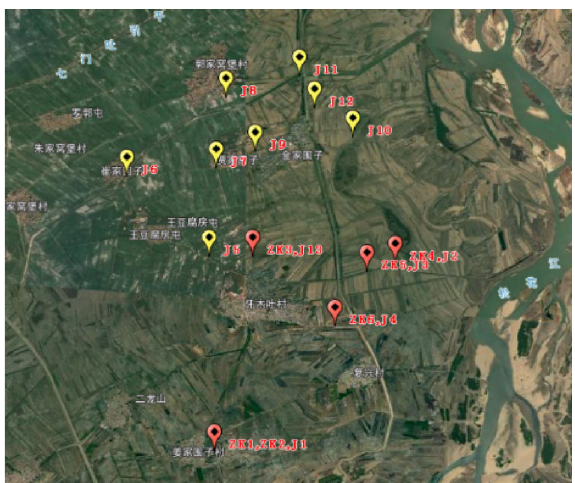
Figure 8. Sites at which drilling and cone penetration test were performed during field survey. ZK and J indicate the sites at which drilling and CPT were conducted respectively. We created this figure in using ArcGIS 10.0 (URL: http:// www. esri.